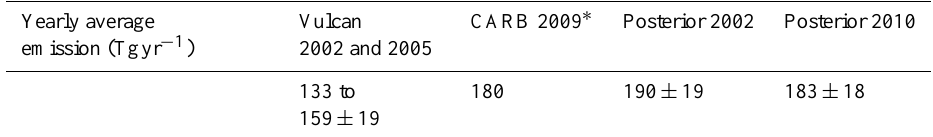
Table 6. Yearly average CO 2 emission in the SoCAB from Vulcan 2002 and 2005, CARB 2009 (from Peischl et al., 2012), and the posteriors in 2002 and 2010. A multiplicative coefficient of 0.78 is applied to the daytime posterior estimates to convert them into yearly average estimates based on Vulcan diurnal